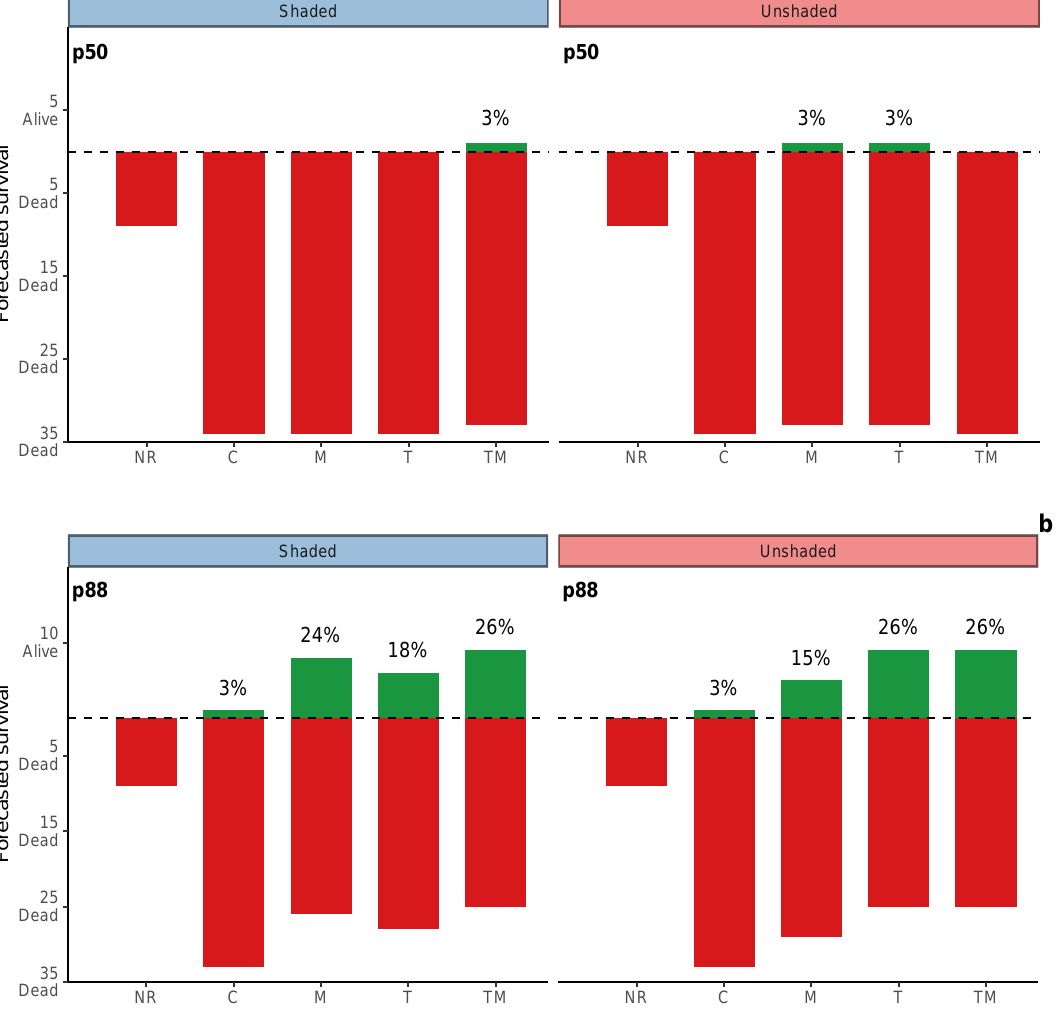
Figure 6. Inferred seedling survival and mortality based on the number of trees in each group with relative water loss < p50 (RWL ≤ 30.13%; Panel ( a )) and p88 (RWL ≤ 44.24%; Panel ( b )), based on estimates from Rosner et al. [41]. Green bars and percentages illustrate survival and red bars illustrate mortality. Table 3. Average needle browning [%], 24-h transpiration following watering treatments [g], relative water loss at the end of the experiment [RWL: %], and number of trees with RWL below the p50 value for pondersoa pine subpopulations (AR: Arapaho-Roosevelt National Forests, PS: Pike & San Isabel National Forests, SR: San Juan-Rio Grande National Forests) in shaded (47% canopy cover) and unshaded (1% canopy cover) microsites. Letters indicate statistically significant differences within the 10 shelter-treatment subgroups, and stars indicate statistically significant groupings between sheltered and unsheltered microsites, determined by ANOVA and Tukey’s honest significant differences ( p <